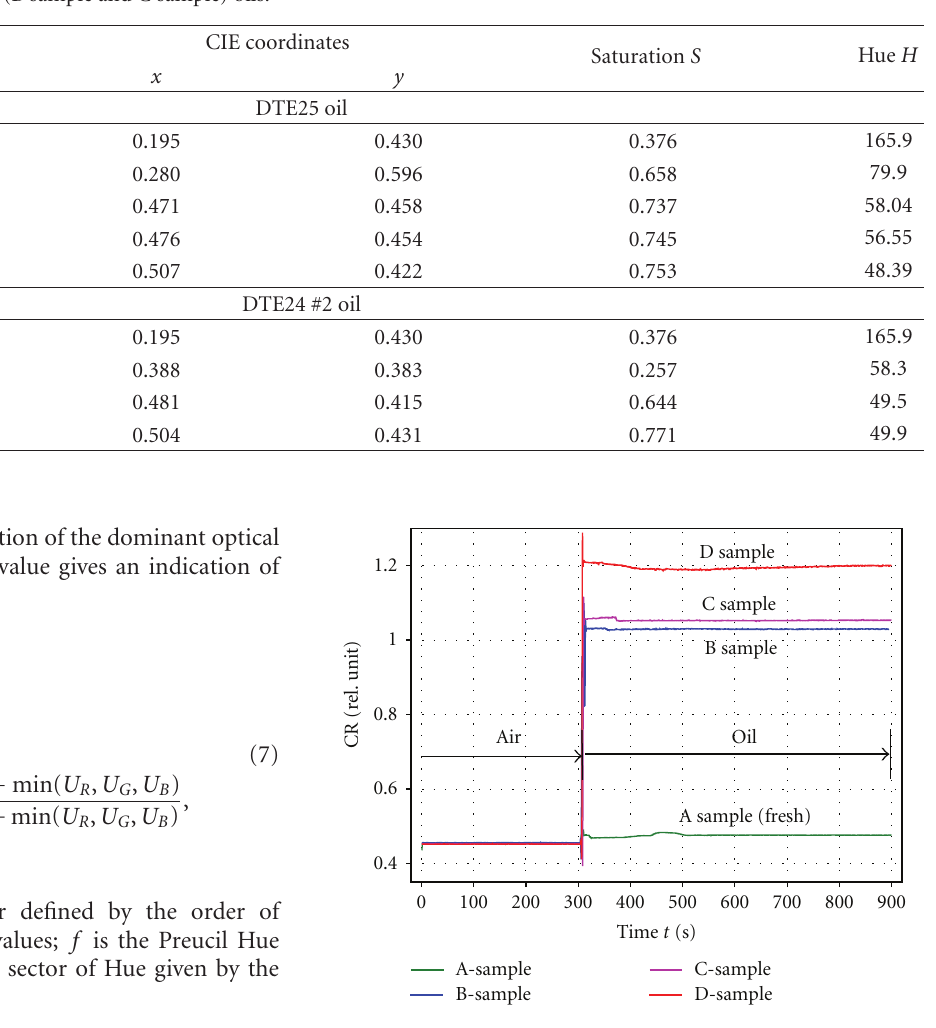
Figure 8: CR-time response of detector in DT25 oil for A sample (fresh), B sample (Aug 30), C sample (Oct 23) and D sample (Jan 10).